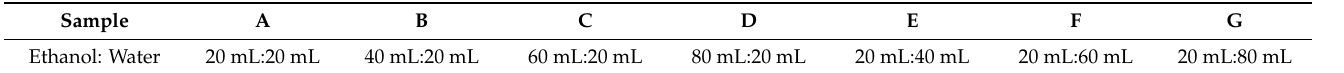
Table 1. Conditions used to obtain the MOF-801